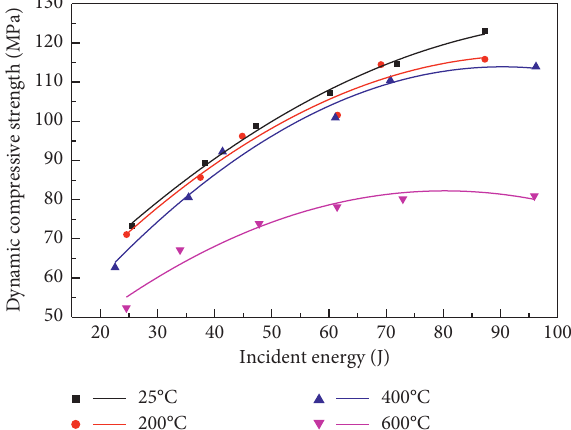
Figure 11: Relationship between dynamic compressive strength and incident energy.